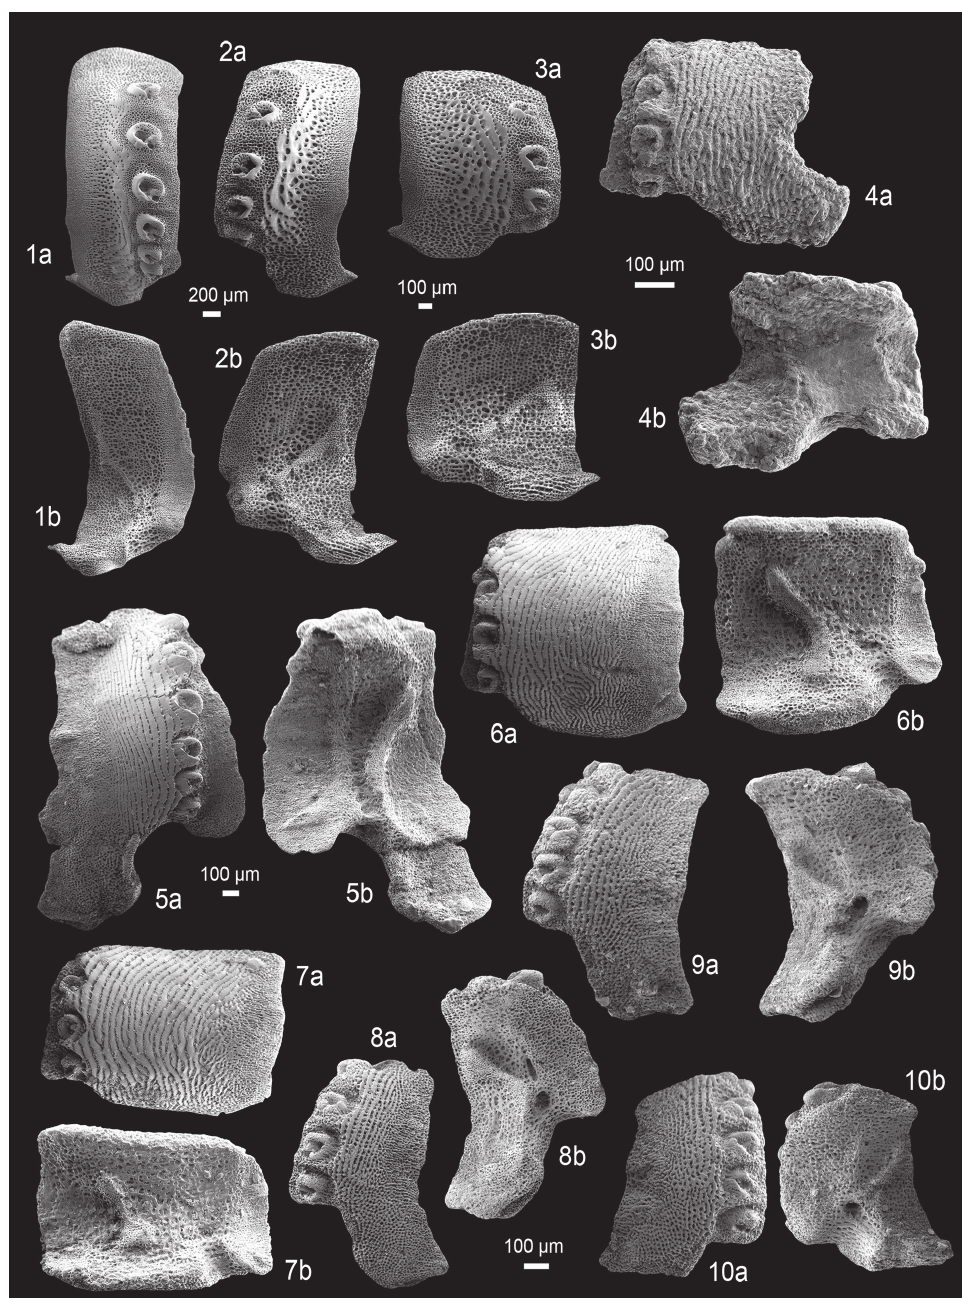
Fig. 12. Lateral arm plates (LAPs) of fossil and Recent ophiacanthid brittle stars in external (a) and internal (b) views. 1. Ophiotoma assimilis Koehler, 1904, Recent, proximal LAP. 2-3. Ophiotoma megatreta (H.L. Clark, 1911), Recent. 2. Proximal LAP. 3. Median LAP. 4. Ophiotoma sp. nov. innom. from the late Sinemurian to early Pliensbachian (Early Jurassic) of the Glasenbach Gorge, Austria; NHMW 2012/0137/0009, median LAP. 5-7. Ophiotoma vadosa sp. nov. from the early Pliensbachian (Early Jurassic) of Blockley, Great Britain. 5. GZG.INV.78541 (holotype), proximal LAP. 6. GZG.INV.78542 (paratype), median LAP. 7. GZG.INV.78543 (paratype), distal LAP. 8-10. Ophiotoma charlottae sp. nov. from the early Kimmeridgian of the Pointe du Chay, France. 8. GZG.INV.78545 (holotype), proximal LAP. 9. GZG.INV.78546 (paratype), proximal to median LAP. 10. GZG.INV.78547 (paratype), distal LAP. One common scale bar per species is